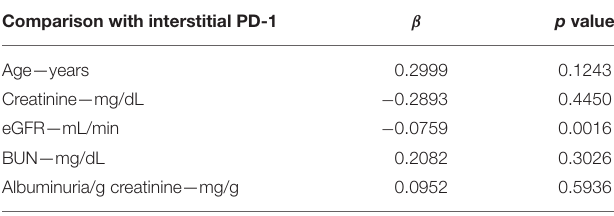
TABLE 3 | Linear regression analyses of PD-1.